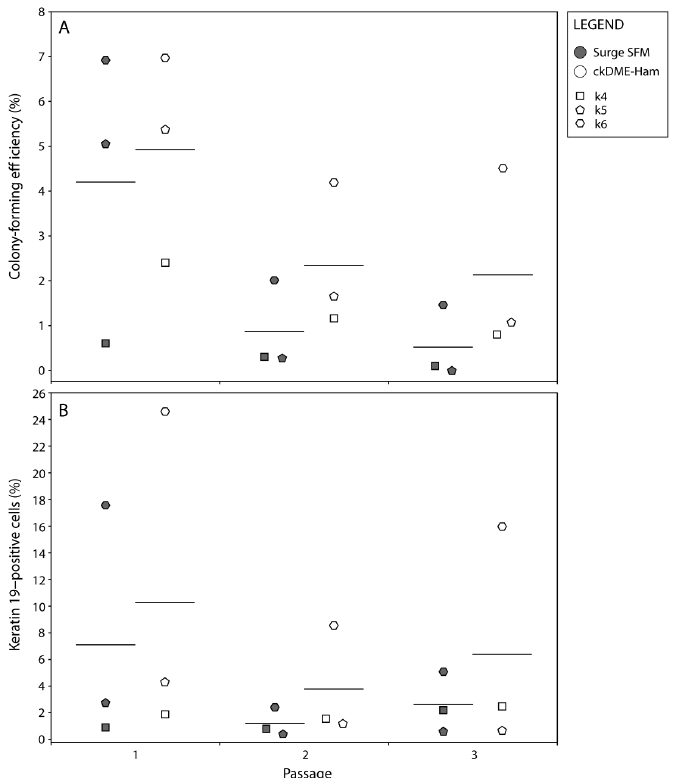
Figure 3. Dot plots of ( A ) keratinocy tes’ holoclone (more than 4 mm in diameter) colony -forming efficiency (%) and ( B ) flow cytometry data for K19-positive cells (%) over three passages. Crossbars represent biological means. Dot fill colors indicate the medium used to culture keratinocytes (gray: Surge SFM and white: ckDME-Ham). Dot shapes identify keratinocyte populations (k4: square, k5: pentagon, and k6: hexagon). Dots are means of quintuplicates in A and means of triplicates in B . Technical variability did not exceed 15%. Isotype controls did not exceed 0.1% K19-positive cells.